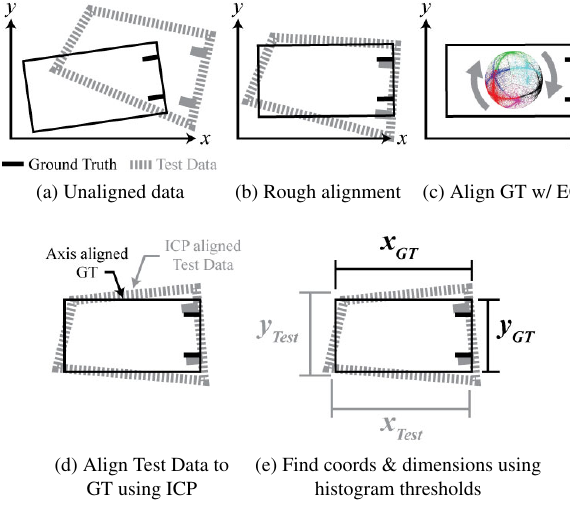
Figure 3. General overview of global